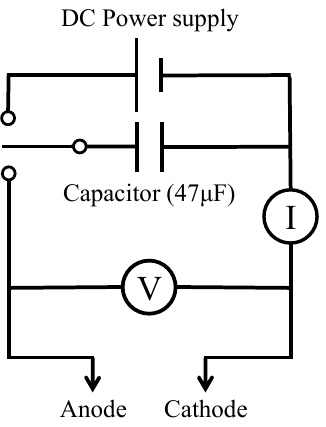
Figure 3. Power supply for short treatment time operation.